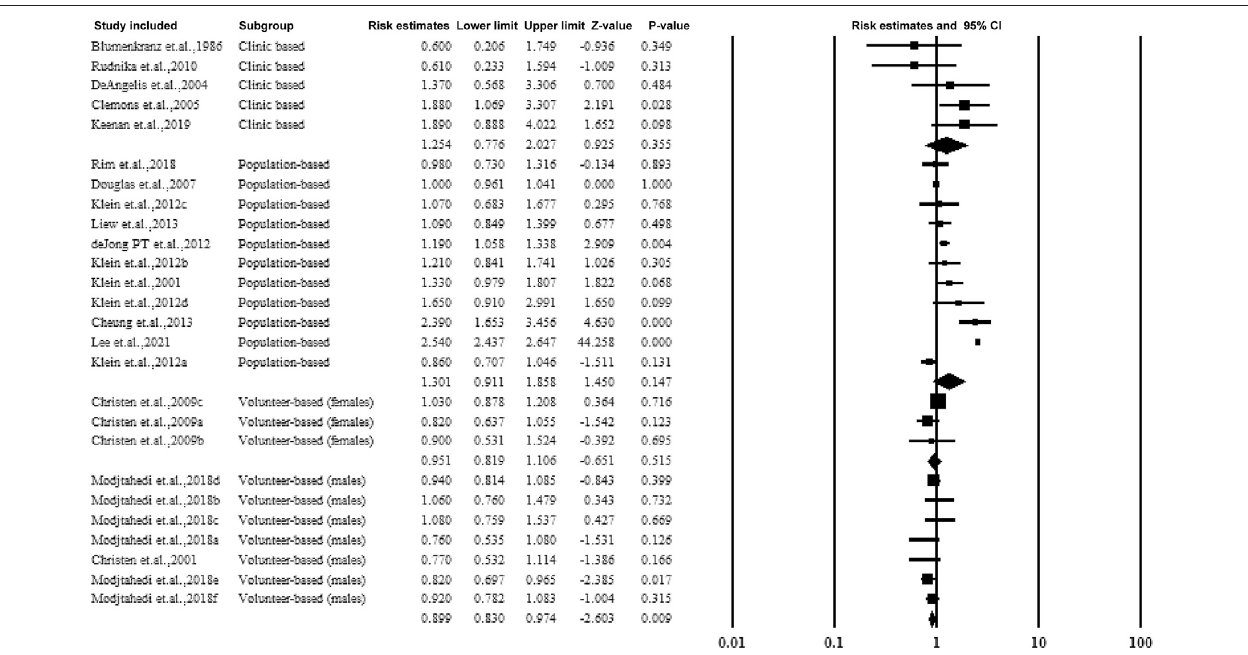
FIGURE 4 | Summarized subgroup analysis according to the source of the participants.